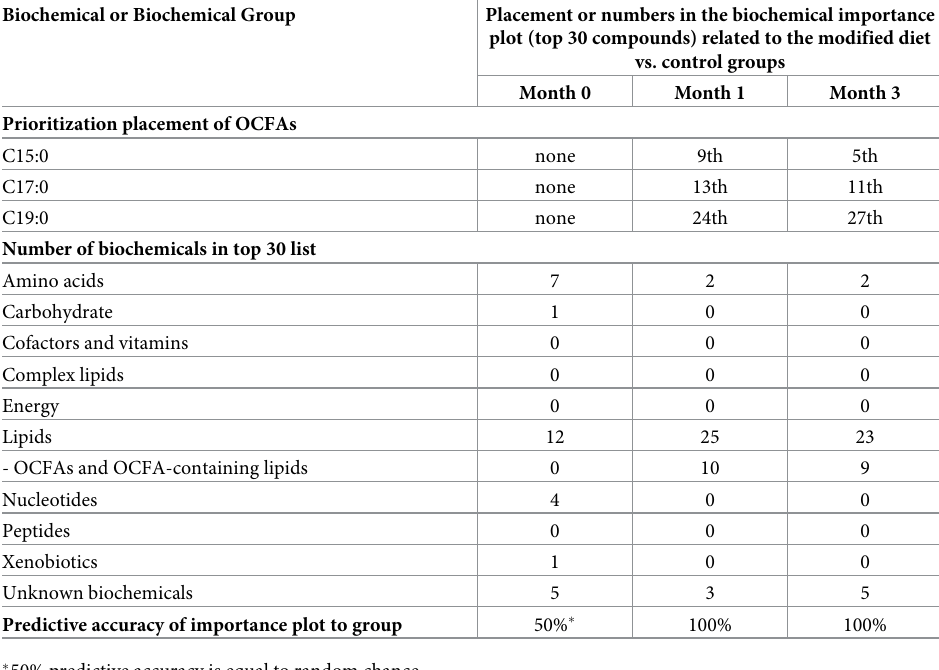
Table 4. Categories of the top 30 prioritized serum biochemicals, based on random forest regression, that changed in the bottlenose dolphin ( Tursiops truncatus ) metabolome due to the modified fish diet. Biochemical or Biochemical Group Placement or numbers in the biochemical importance plot (top 30 compounds) related to the modified diet